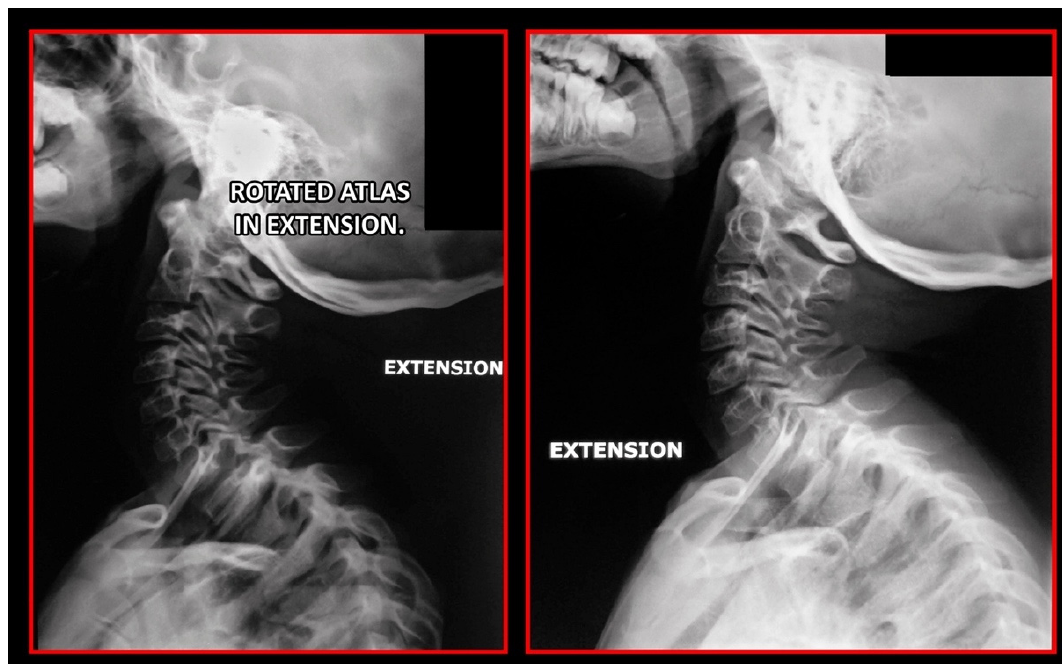
Figure 12. Rotation of the atlas on lateral cephalometric radiograph. Left: Pre-treatment. Double ring of the atlas showing its rotation. Decreased functional spaces. Right: After orthopedic manual therapy. Only one posterior arch of the atlas showing the normalization of atlas rotation. Normalized functional spaces.